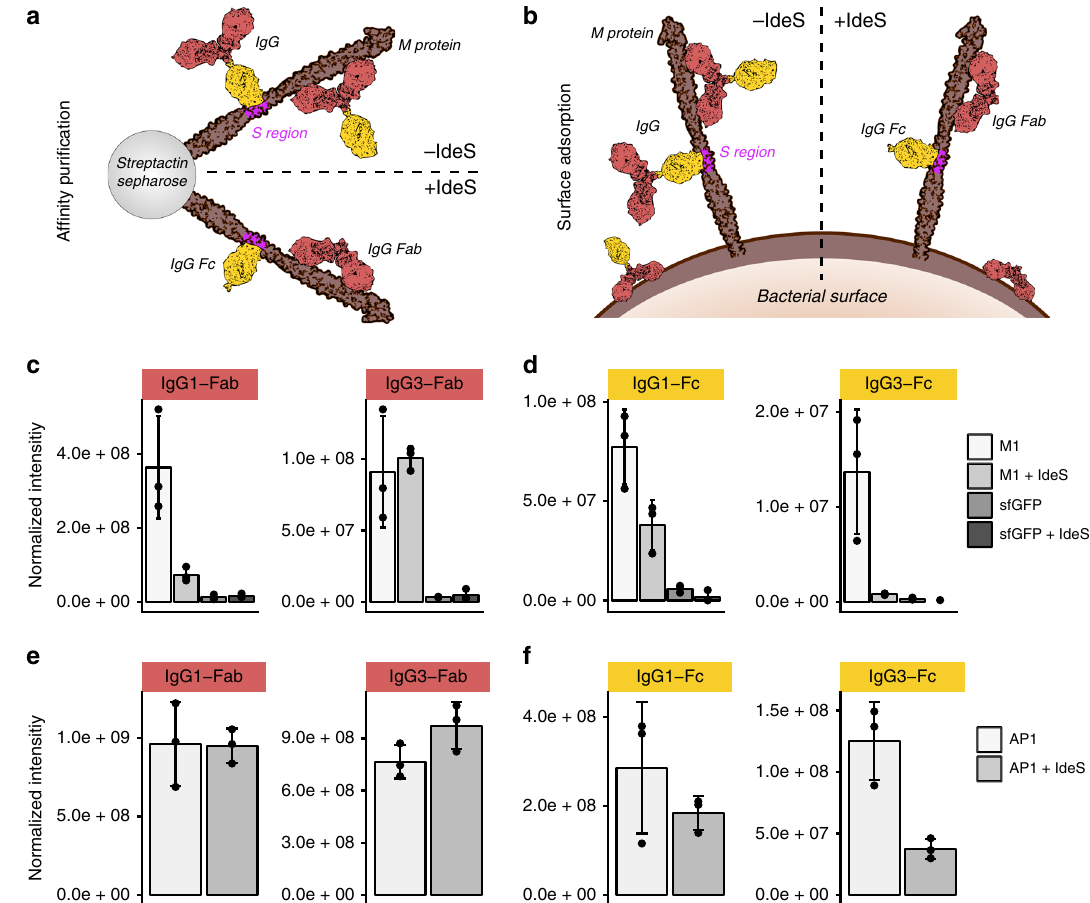
Fig. 7 Plasma IdeS pre-treatment in AP – DIA and SA – DIA. a IgG binding in AP – DIA experiments in non-treated plasma and plasma pre-digested with IdeS. b IgG binding in SA – DIA experiments in non-treated plasma and plasma pre-digested with IdeS. c , d Quanti fi cation of Fab and Fc-speci fi c signature peptides after IdeS cleavage using targeted MS analysis after af fi nity puri fi cation on the M1 protein. sfGFP was used as a negative control. e , f Quanti fi cation of Fab and Fc-speci fi c signature peptides after IdeS cleavage using targeted MS analysis after af fi nity puri fi cation using whole wild-type M1 serotype AP1 bacteria. Error bars are expressed as standard deviation (s.d.) from the mean. All experiments were prepared using n = 3 biologically independent samples. Source data are provided as a Source Data fi